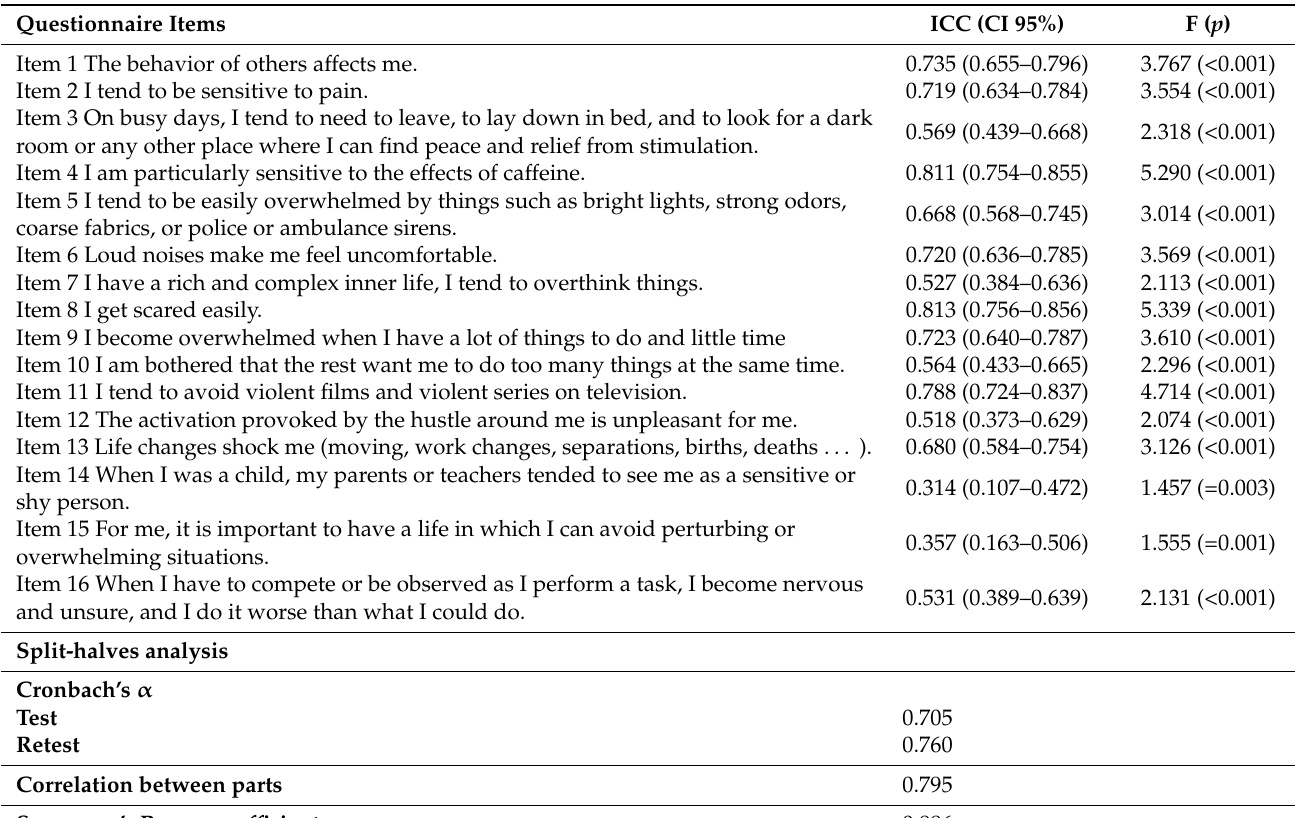
Table 5. Association between each factor of the R-HSP scale and personal attribute of Spanish uni- versity students.